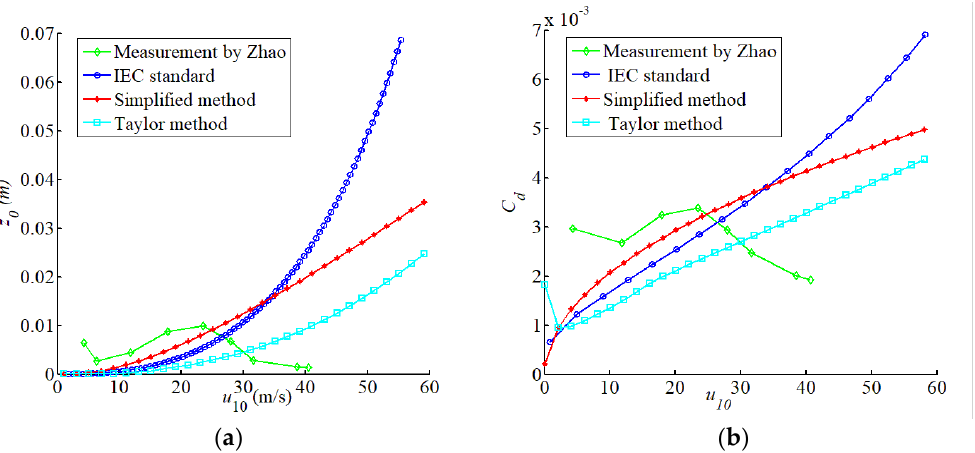
Figure 7. ( a ) The comparison of z 0 changed with wind speed calculated by different methods; ( b ) The comparison of 𝐶 d changed with wind speed calculated by different methods.